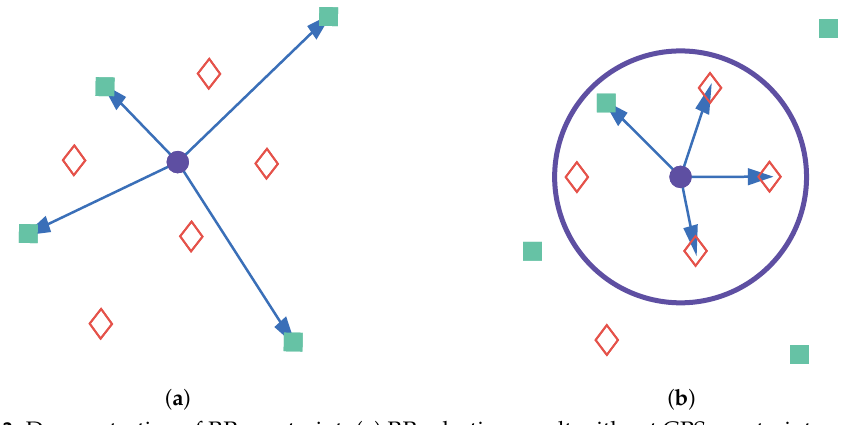
Figure 3. Demonstration of RP constraint: ( a ) RP selection result without GPS constraint; and ( b ) RP selection result with GPS constraint. In ( a , b ), the purple circles are TPs. In ( a ), cyan rectangles connected with TP by arrows are selected RPs and red diamonds are RPs not selected for computation of TP’s position. In ( b ), points connected with TP by arrows are selected RPs, the purple circle shows the constraint